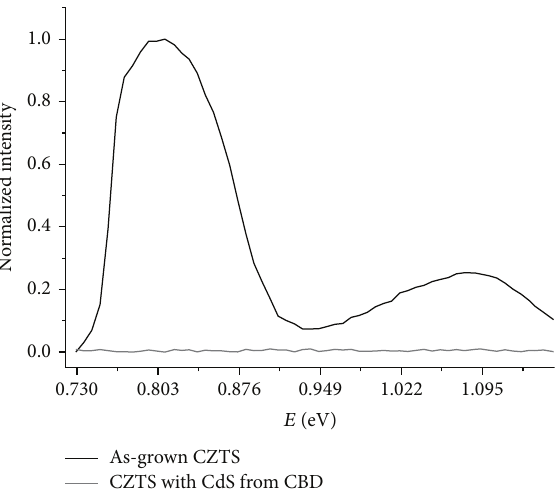
= 1064 nm, 𝑃 = 6 W/cm 2 ) of exc exc